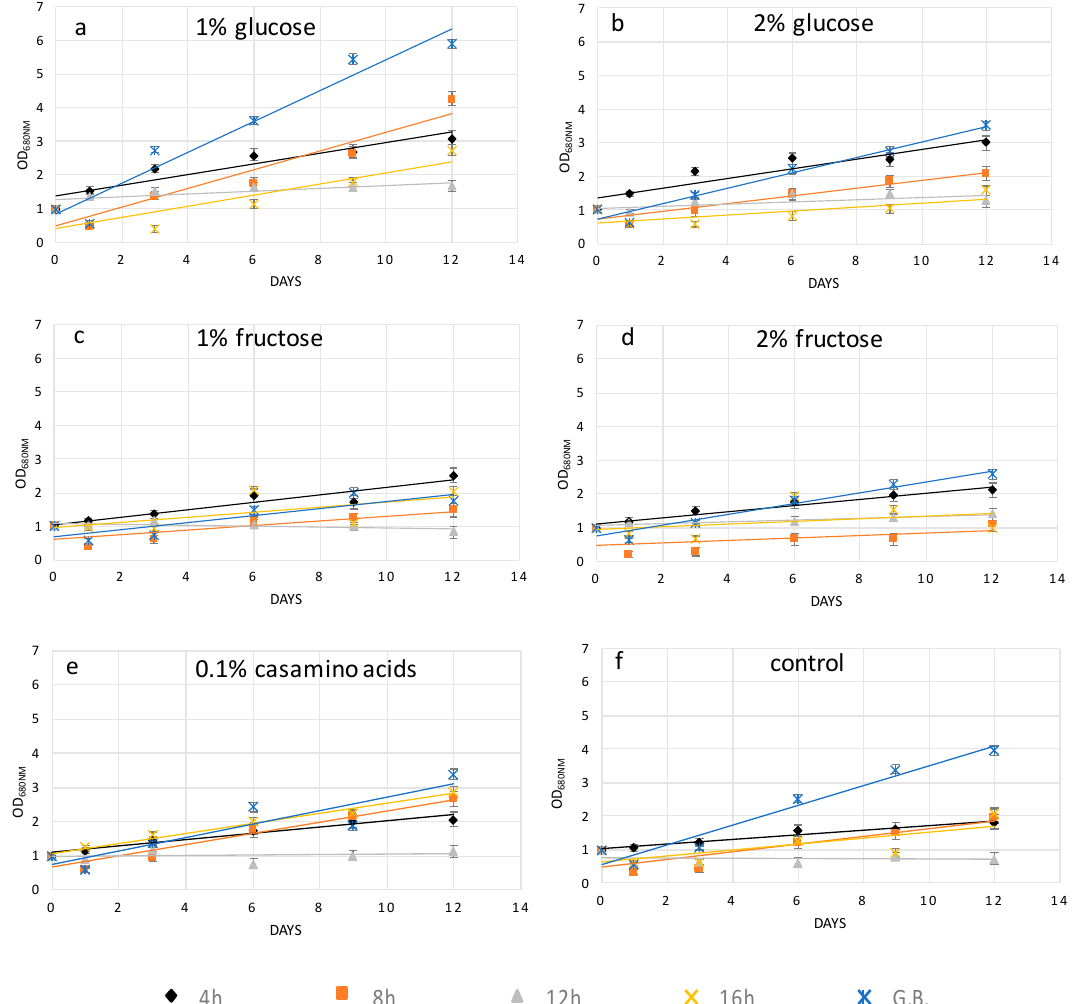
Figure 3. Recovery trend lines of H. pluvialis cells before and after enzymatic (4, 8, 12, 16 h) / mechanical treatment in media supplemented with ( a ) 1% glucose; ( b ) 2% glucose; ( c ) 1% fructose; ( d ) 2% fructose; ( e ) 0.1% casamino acids; and ( f ) control.